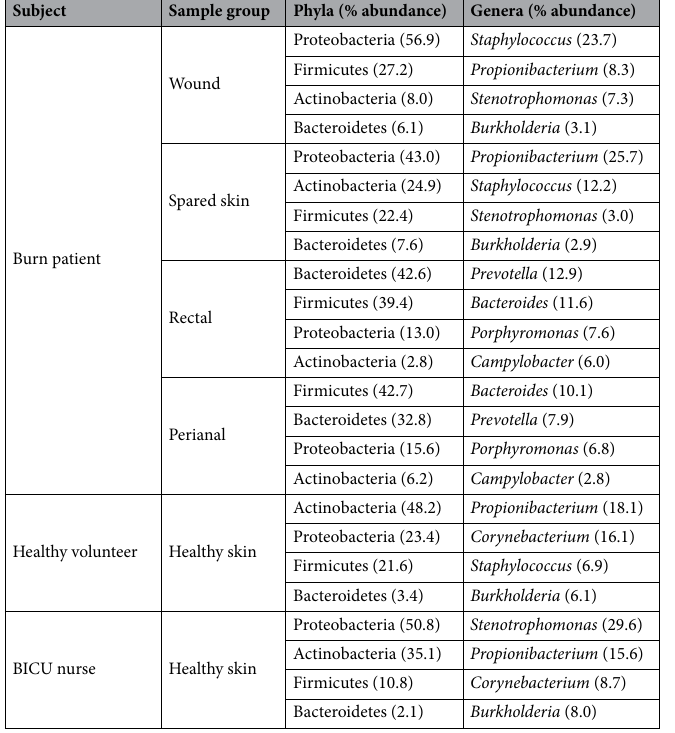
Table 3. Predominant taxa by sample group. In descending order, the top four most predominant phyla and genera as determined by percent relative abundance summed by sample group among burn patients, healthy volunteers, and BICU nurses. Percent abundance represents the frequency of each phyla or genera divided by the sum of frequencies for each